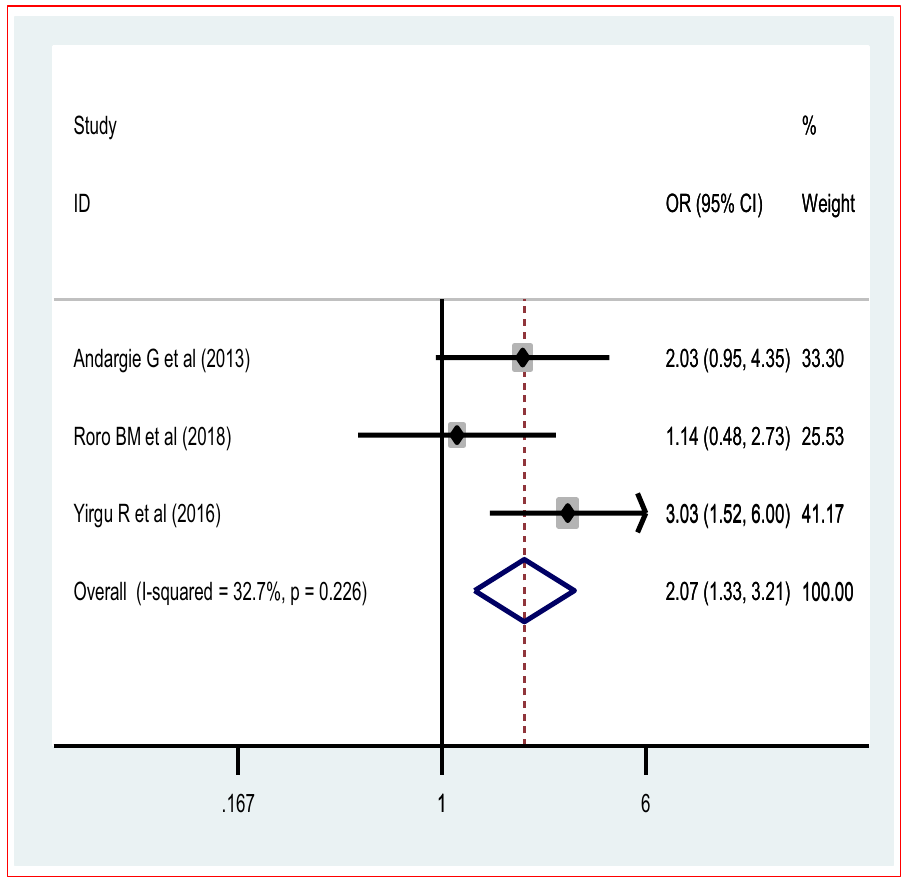
Figure 9. Pooled odds ratio on association of previous abortion and perinatal